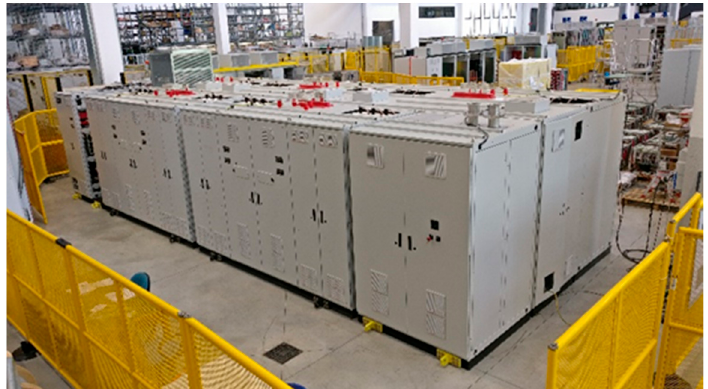
Figure 10. Setup of the test.